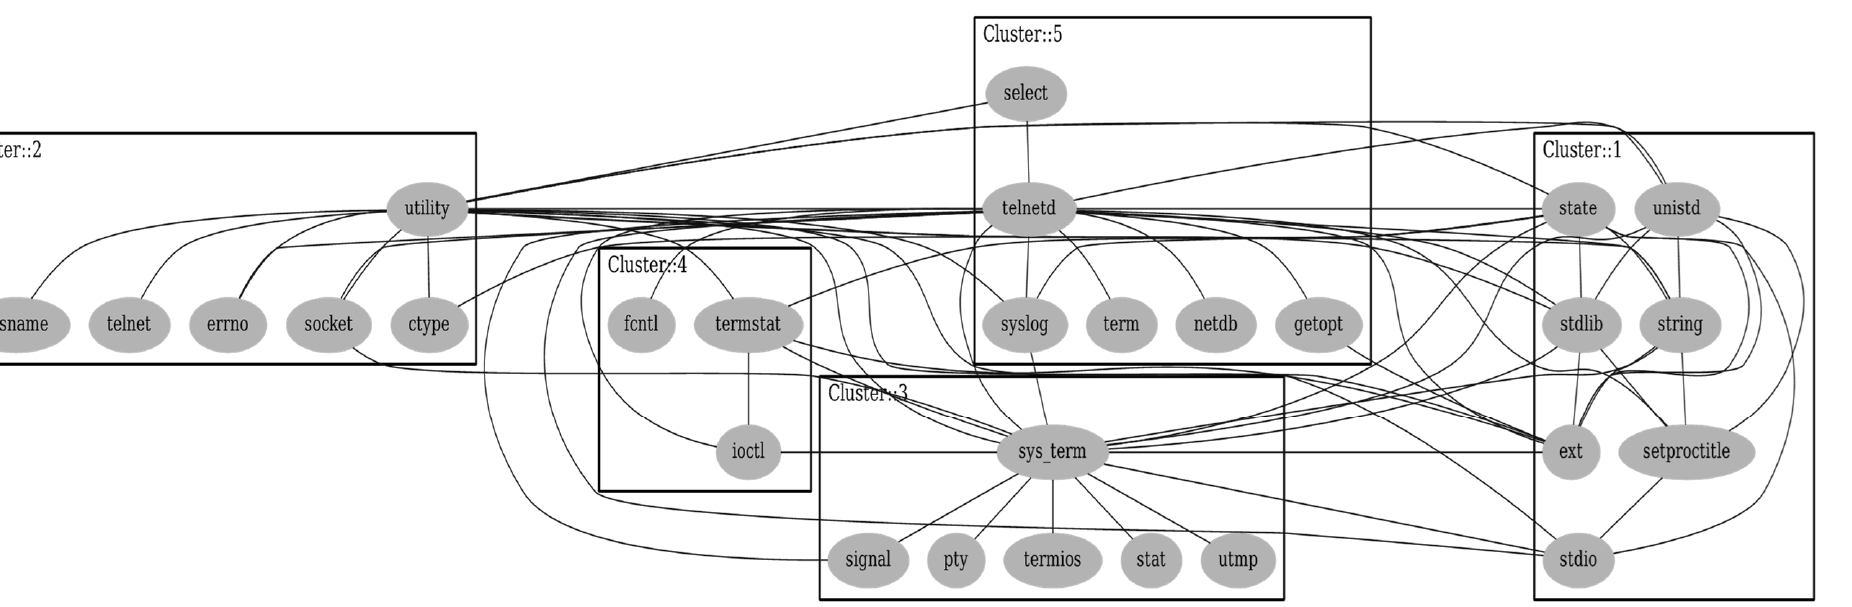
Figure 9. Telnet2 system after applying the HHMO_CF_GDA approach.